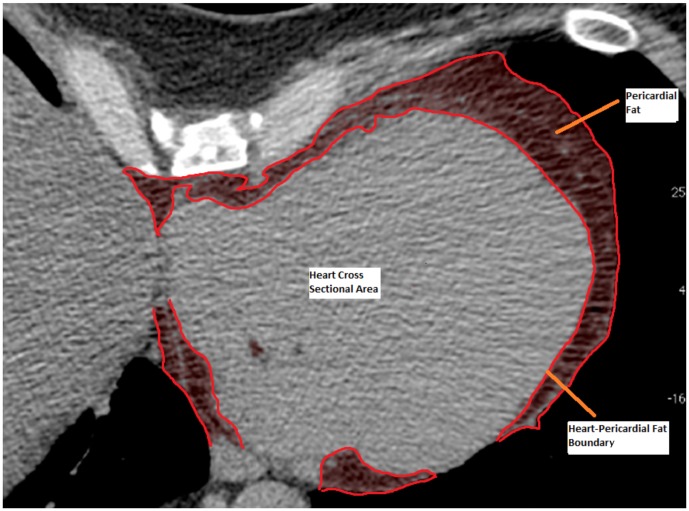
Cross sectional (axial) area of pericardial fat (PF).Colored image outlining axial PF area boundaries. Cardiac silhouette in grey, within PF and labeled.